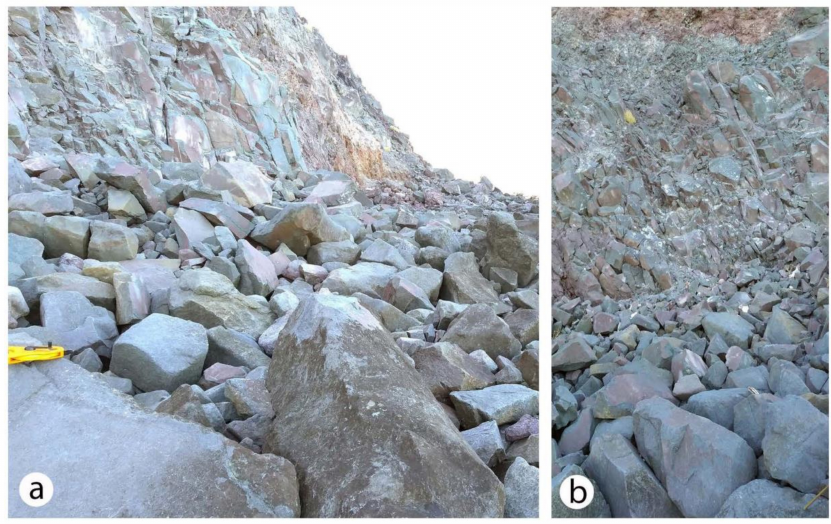
Figure 3. Rocky shore and intertidal zone at cli ff s adjacent to the marine terrace and near the start of the 450-m long spit on Isla San Luis Gonzaga; ( a ) Oblique view with housing of meter tape for scale; ( b ) Head-on view showing tilted andesite flows in the